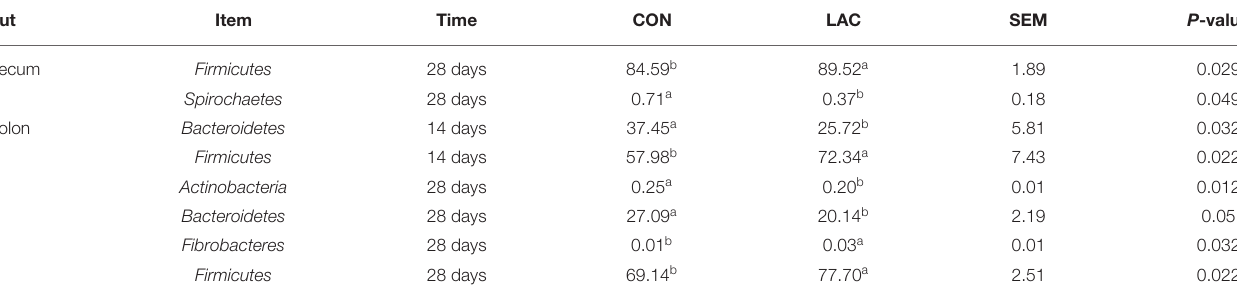
FIGURE 4 | Effects of Lactobacillus delbrueckii on the bacterial community at the phylum level in the guts of the weaned piglets. AHM, AMM, and AJM represent ileum, cecum, and colon samples of the CON group, respectively; BHM, BMM, and BJM represent ileum, cecum, and colon samples of the LAC group, respectively; 14 and 28 represent the 14 and 28 days of the trial period, respectively.